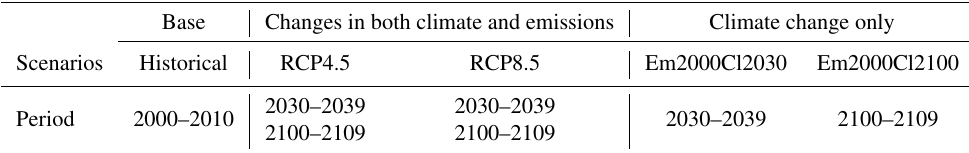
Table 1. Scenarios used in this study. Base Changes in both climate and